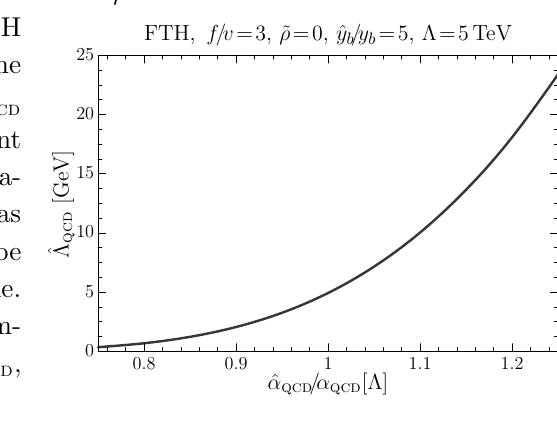
Figure 9 . The twin con(cid:12)nement scale ^(cid:3) qcd